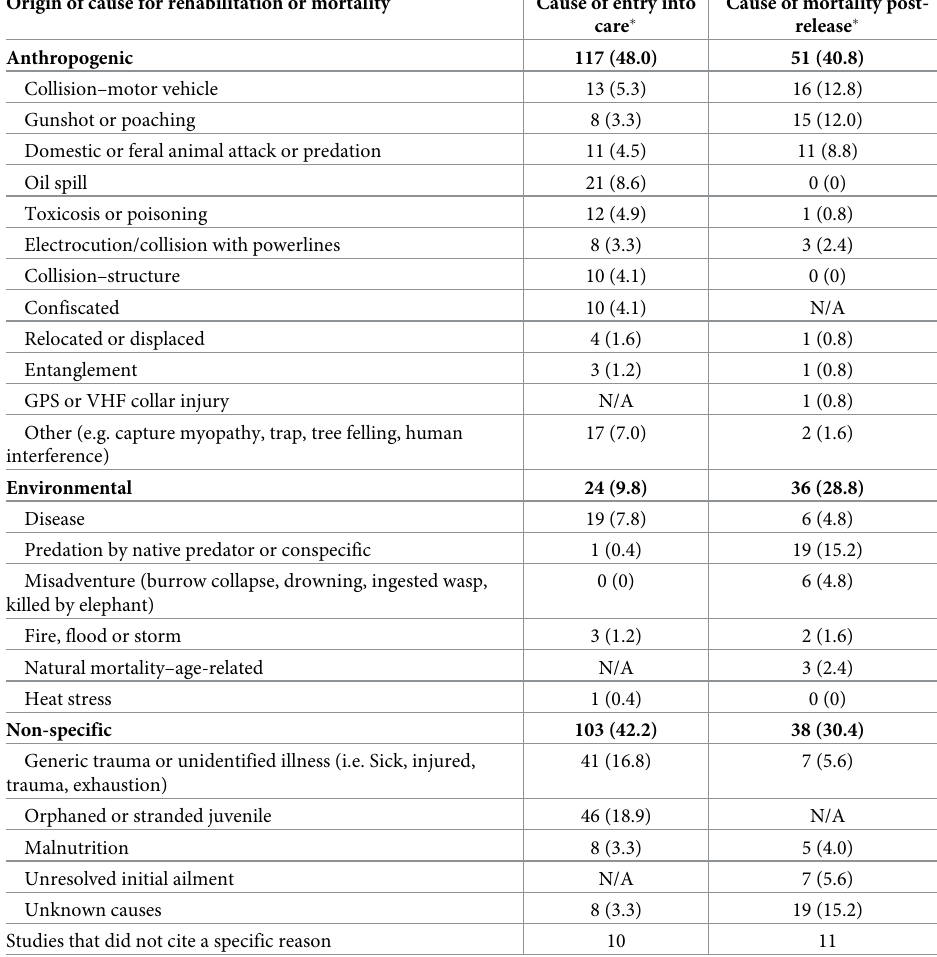
Table 2. Frequency of studies reporting various anthropogenic, environmental and non-specific causes for entry of wildlife into care, and mortality